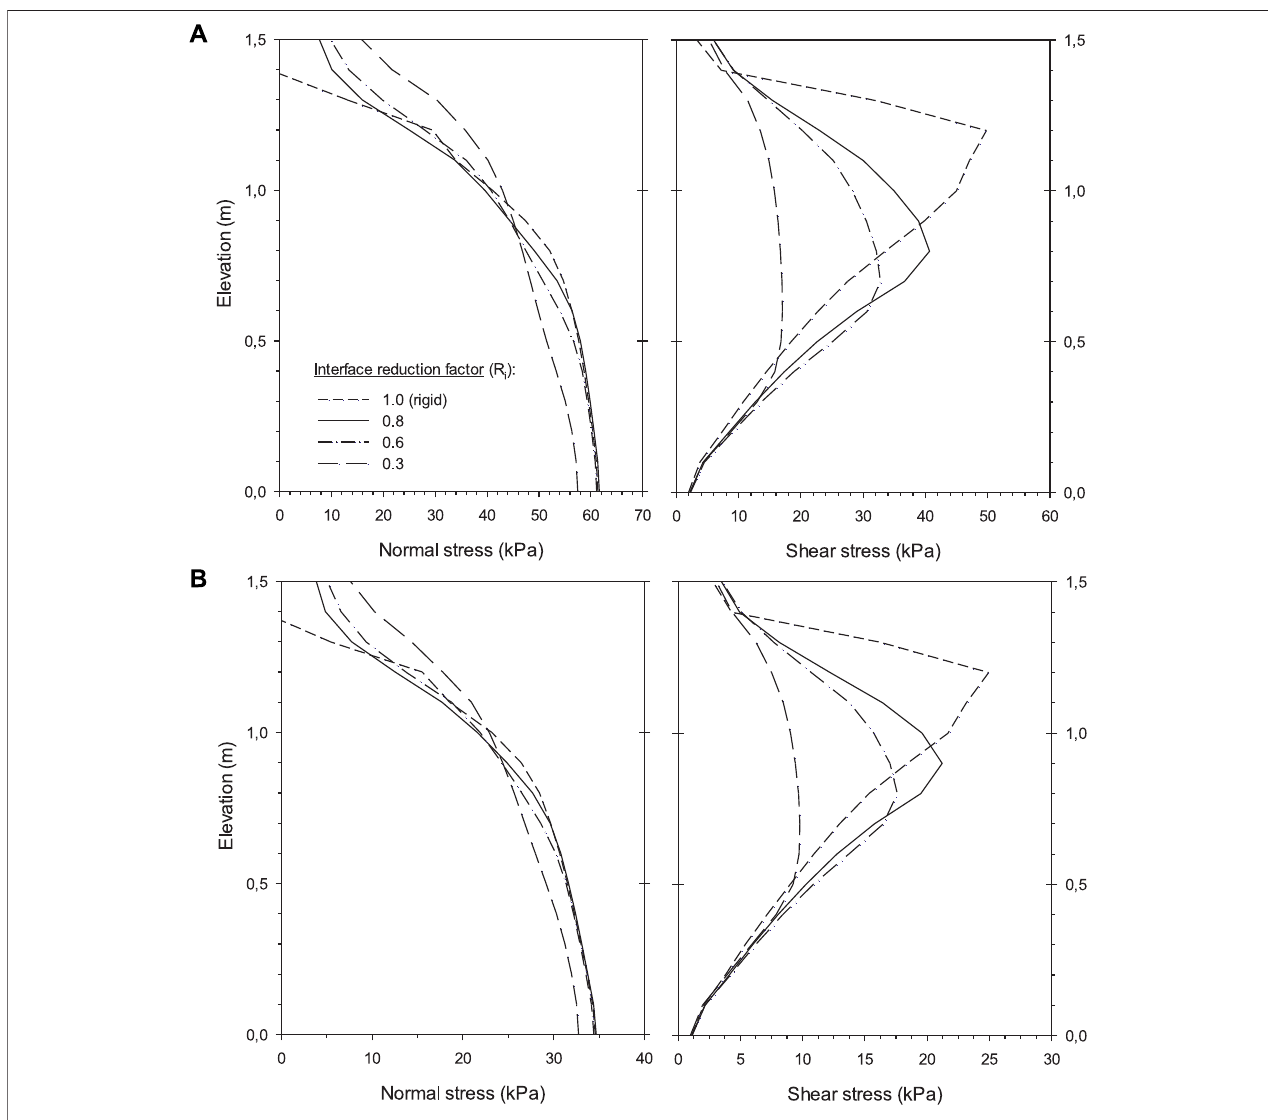
FIGURE 13 | Load transfer from back fi ll soil to facing panel using program CODE_BRIGHT: comparison of normal and shear stresses with different interface strength/stiffness reduction factor (Ri values). Cases with (A) q = 100 kPa and (B) q = 50 kPa.